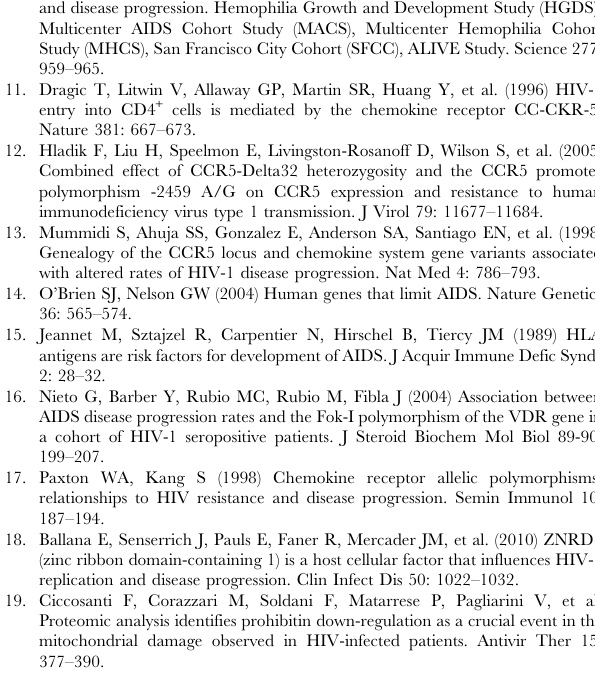
Table S1 MicroRNAs over expressed in HIV-1 NL43 infected cultures compared to uninfected control cells.